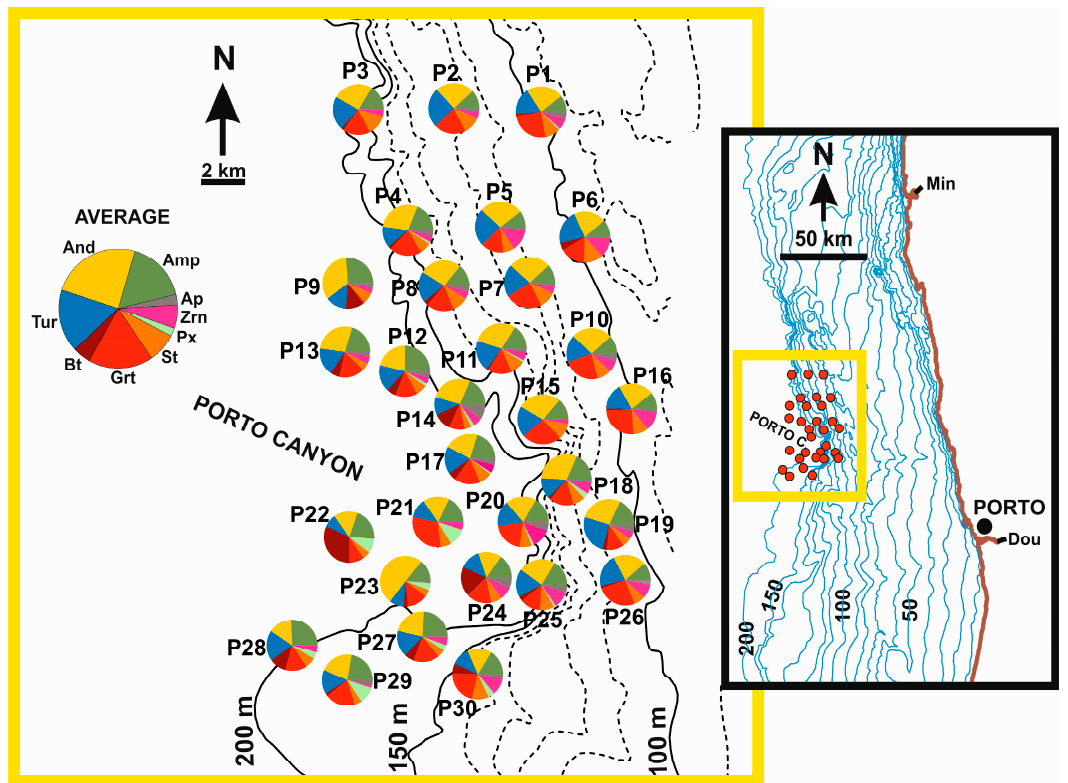
Figure 5. Main heavy mineral suite distribution according to the samples collected from the Porto upper canyon area. The average values are represented on the larger pie chart.